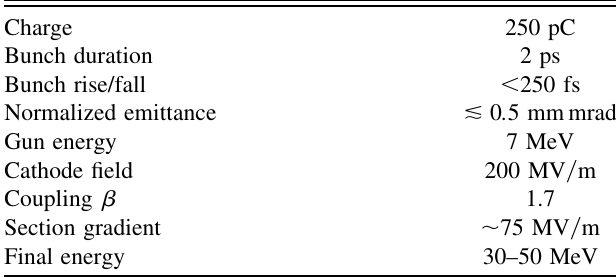
TABLE IV. LLNL test station